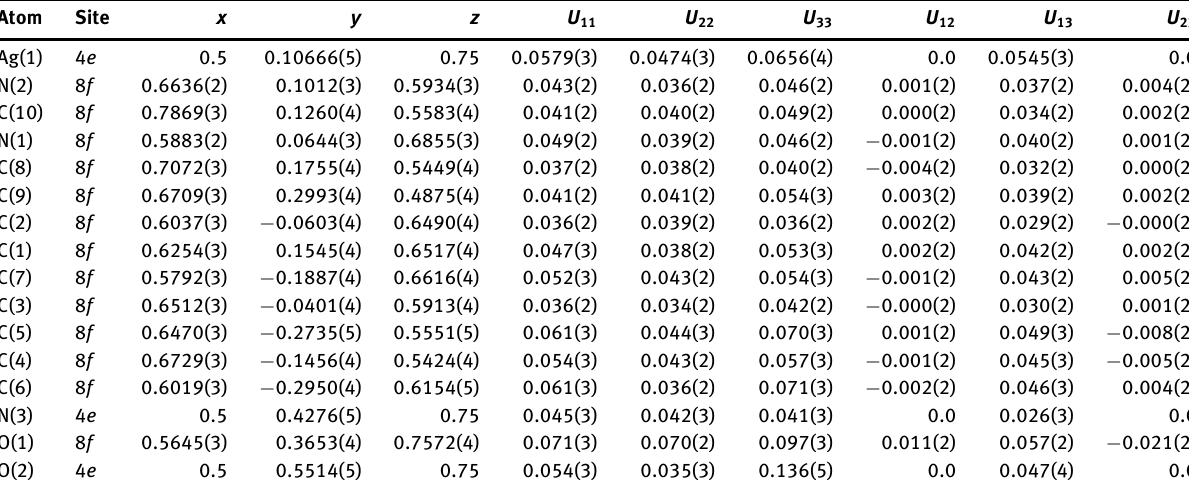
Table 3: Atomic displacement parameters (Å 2